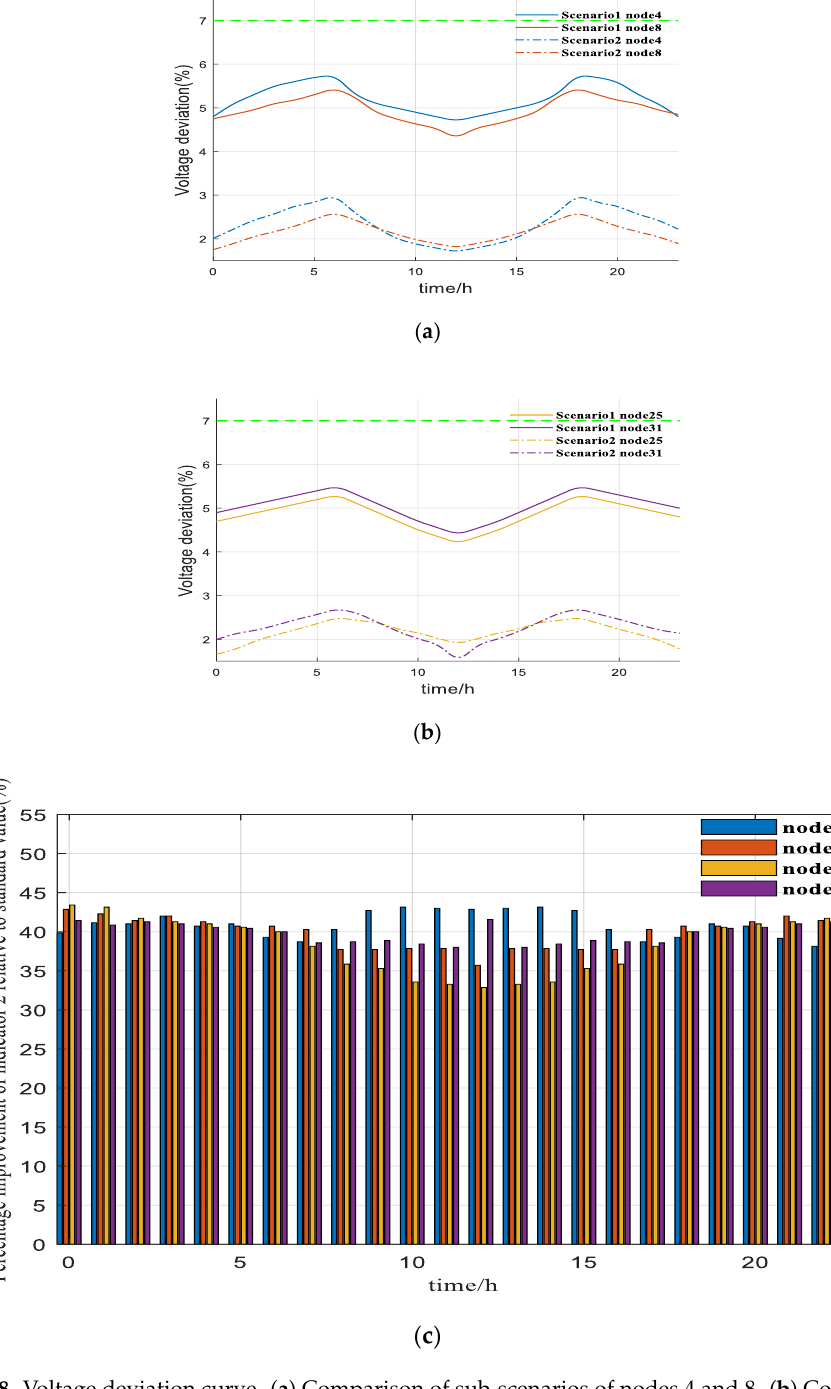
Figure 8. Voltage deviation curve. ( a ) Comparison of sub-scenarios of nodes 4 and 8. ( b ) Comparison of sub-scenarios of nodes 25 and 31. ( c ) Percentage improvement of voltage deviation relative to standard